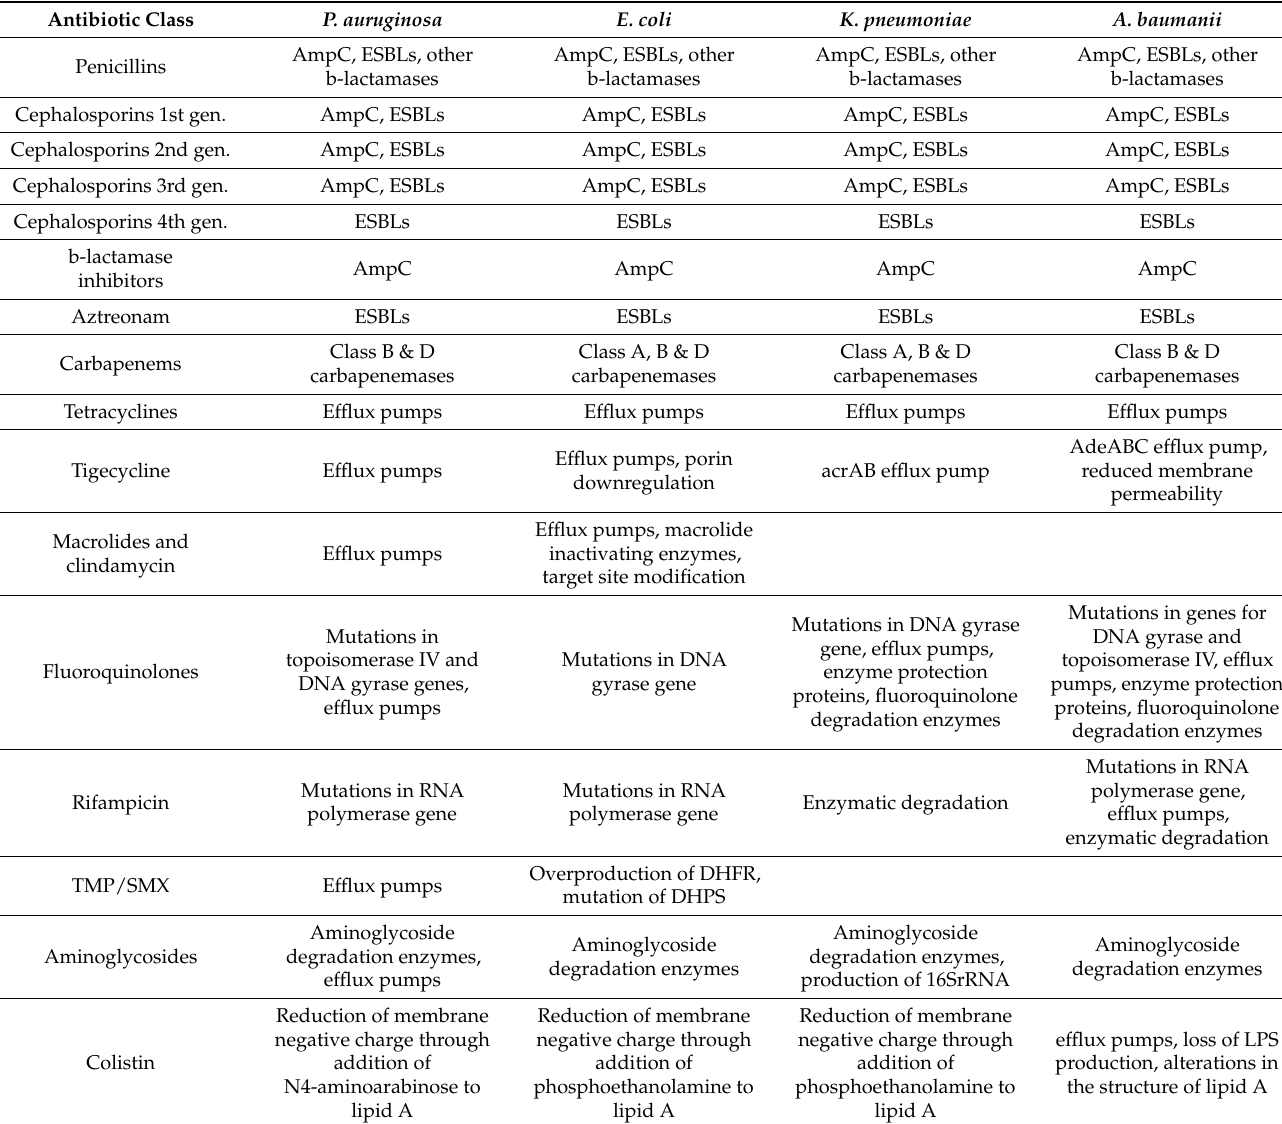
Table 3. Summary of antibiotic resistance mechanisms in important Gram-negative